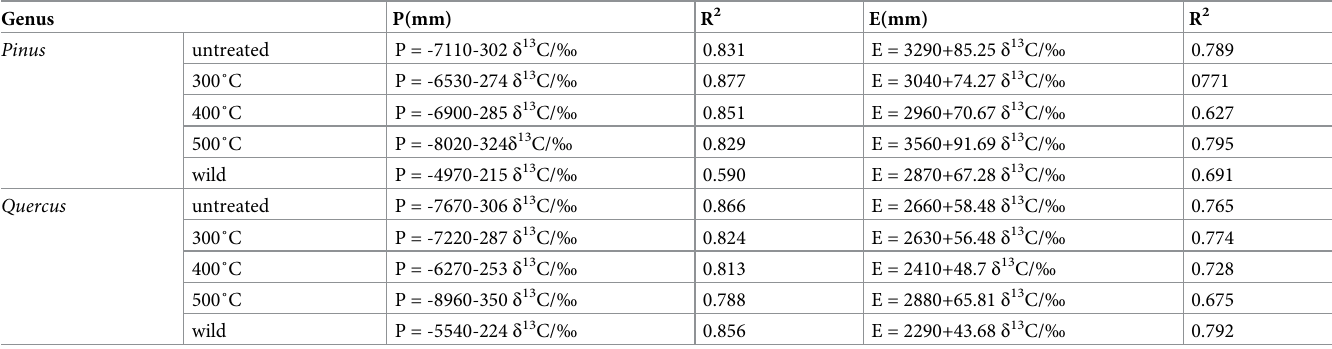
Table 5. Linear regression analysis of δ 13 C (‰ VPDB) of charcoal (P is precipitation; E is evaporation).